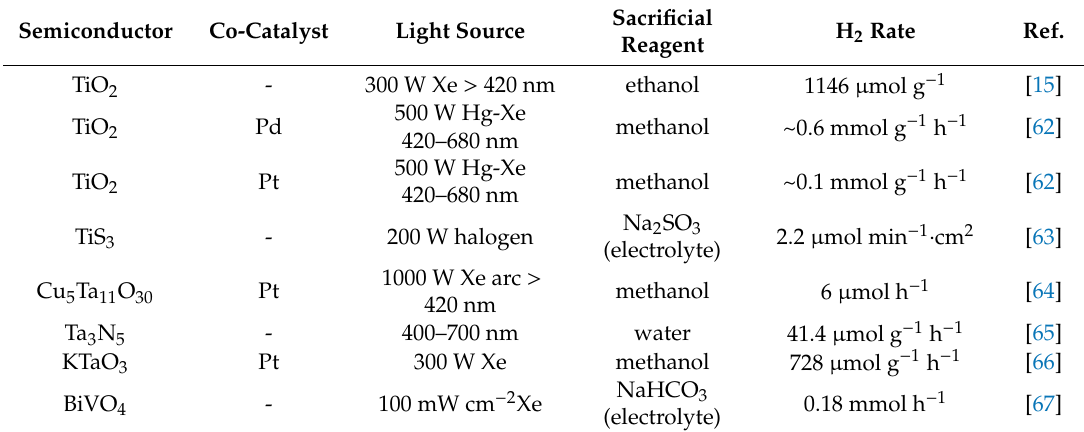
Table 2. Summary of Nb-doped photocatalysts employed for H 2 eVolution from aqueous solution.